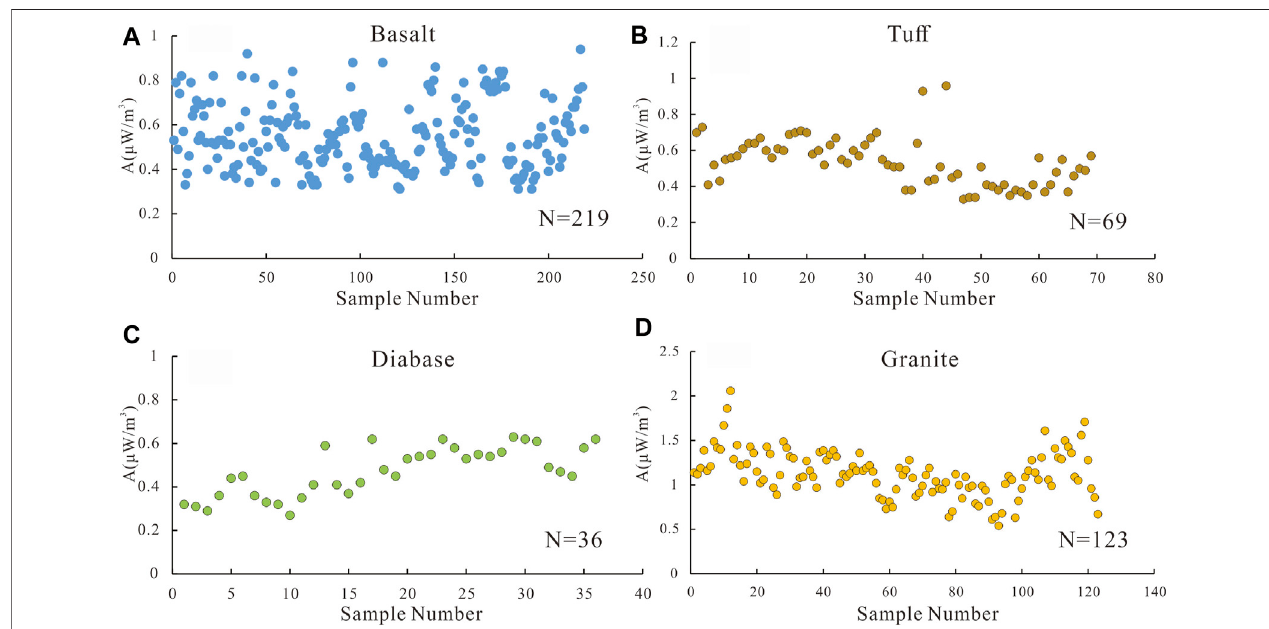
FIGURE 5 | Scatter plot of calculated heat production of different kinds of igneous rocks. (A) Basalt; (B) Tuff; (C) Diabase; (D) Granite.